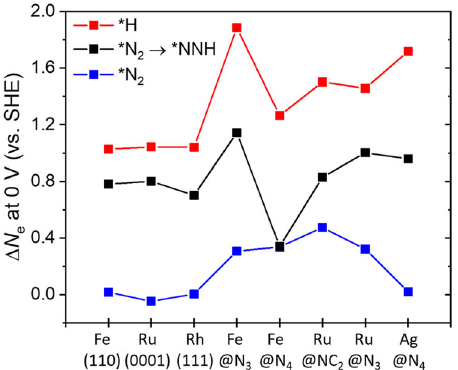
Fig. 7 The amount of electron transfer ( Δ N e ) in *H, *N 2 , and *NNH formation at 0 V. Black, red, and blue colors represent *NNH formation from *N 2 , *H formation, and *N 2 formation,